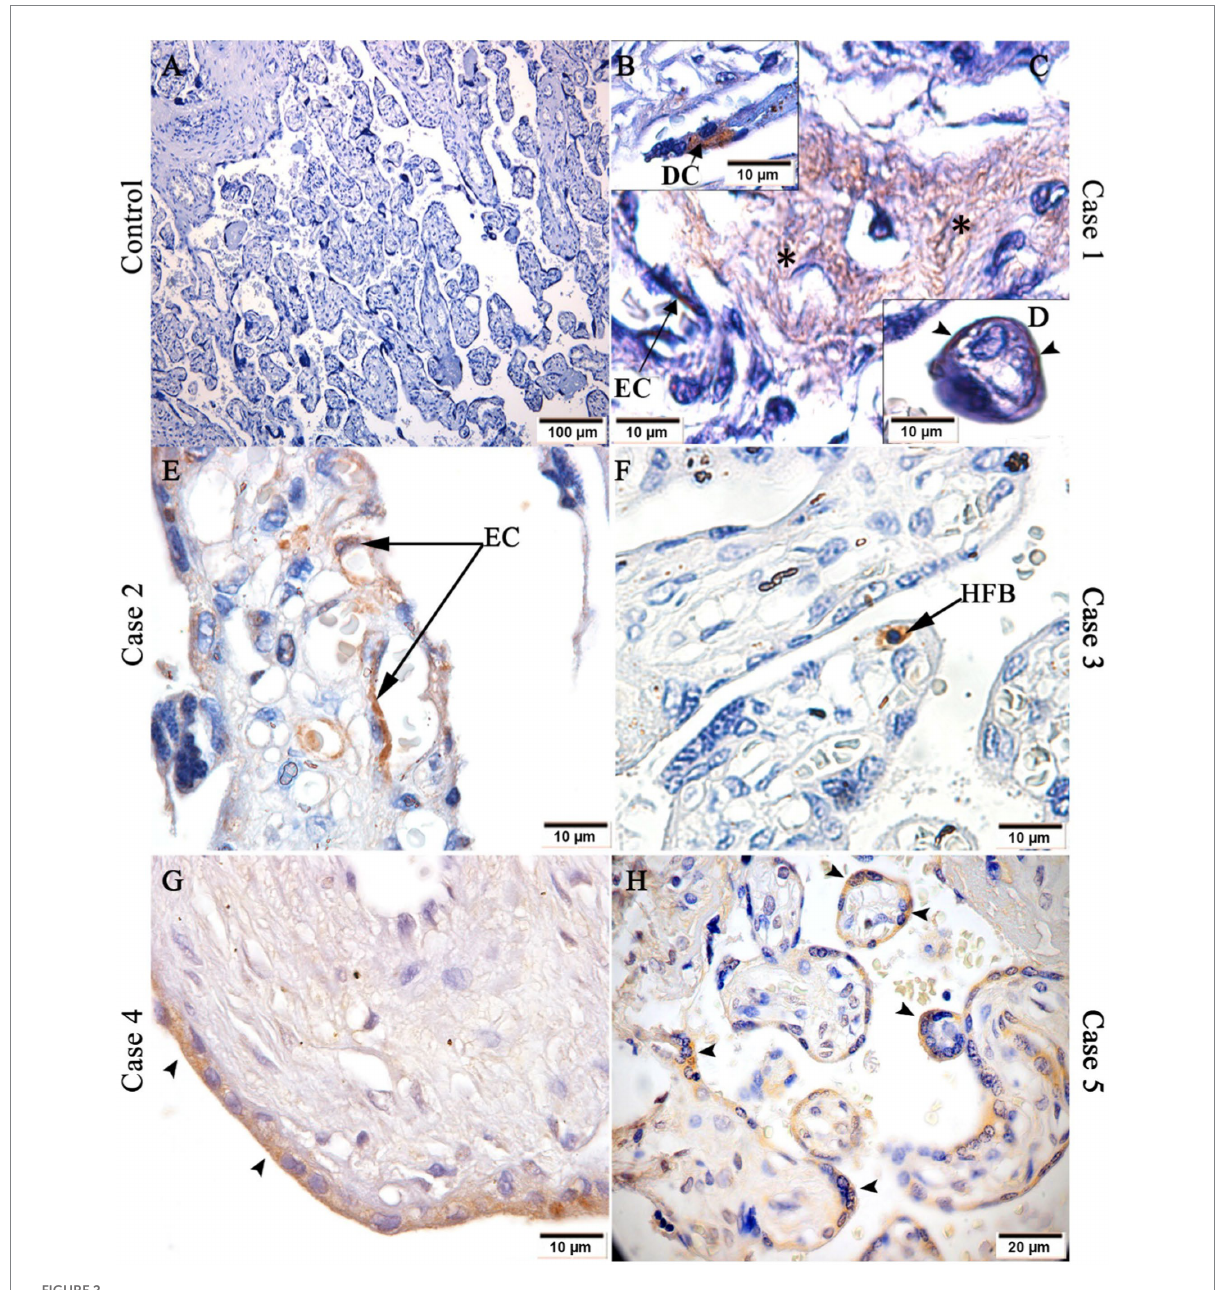
FIGURE 2 Detection of CHIKV antigen in placental tissue. (A) Control placenta with no CHIKV antigen detection; CHIKV antigen detection in: (B) decidual cell, (C) endothelial cell and stroma (black asterisks) of chorionic villi and (D) trophoblastic cells of case 1, (E) endothelial cells (EC) of case 2; (F) Hofbauer cell (HFB) of case 3; (G) trophoblastic cells of case 4; and (H) trophoblastic cells of case 5. Magnification: 10× (A) , 40× (H) , 100× (B–G)